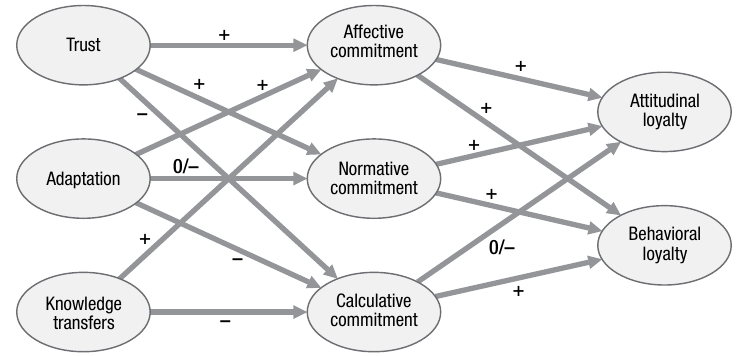
Fig. 2. Proposed conceptual model of commitment based on the IMP